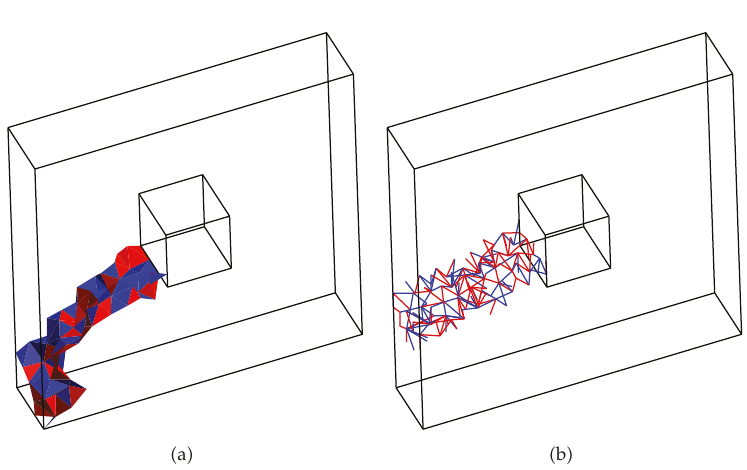
Figure 5: (cid:6) a (cid:7) : A representative of the generator of H 2 (cid:6)Ω ,∂ Ω(cid:7) of a toroid. (cid:6) b (cid:7) : A representative of the same generator but in terms of primal mesh cells, so-called thick-cut, computed by applying coreduction to C (cid:6)Ω(cid:7)